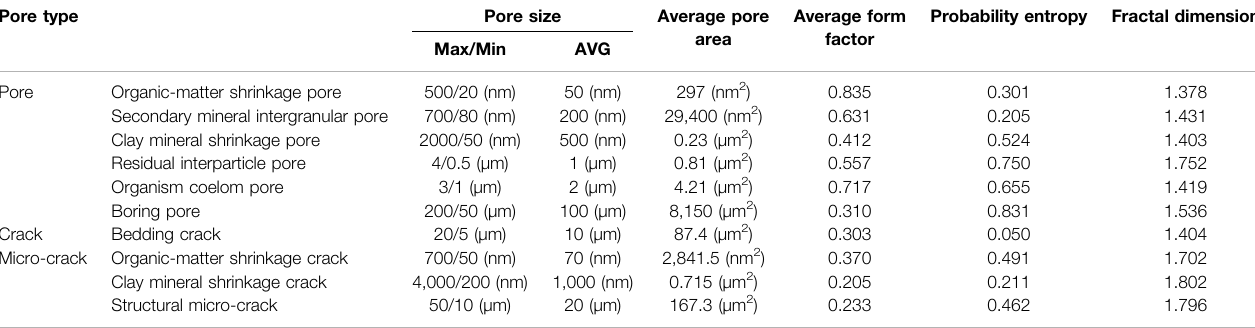
Average form Probability entropy Fractal dimension area factor Max/Min AVG